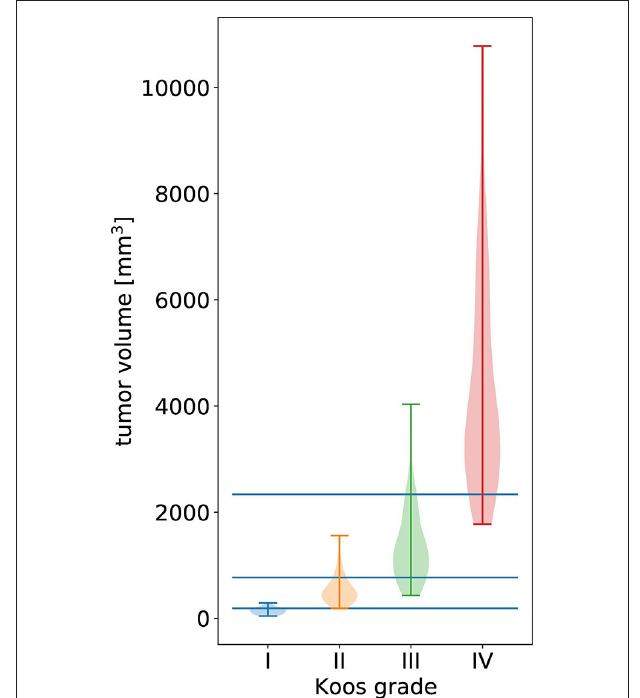
FIGURE 3 | Violin plot of all tumor volumes in the dataset over the ground truth Koos grade. The width of the colored shapes approximately represents the distribution tumor volumes of the Koos grade’s samples. The three horizonal lines represent the tumor volume thresholds that optimally separate all samples in terms of weighted F1